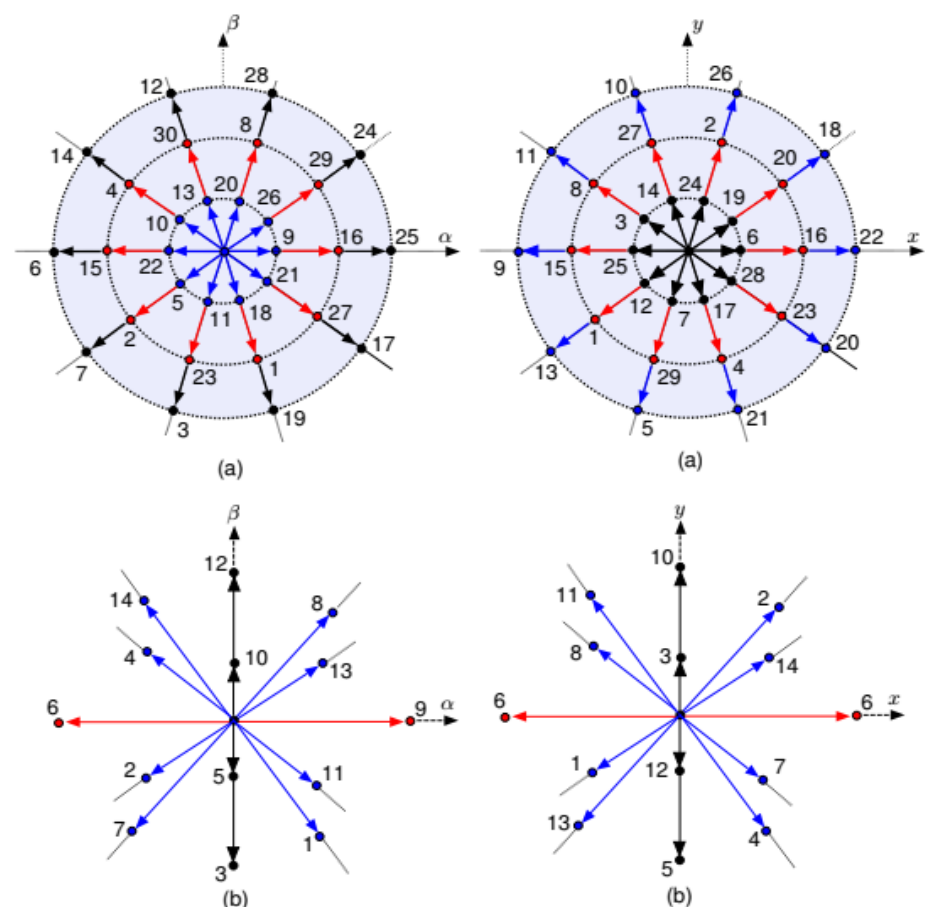
427 407 410 411 412